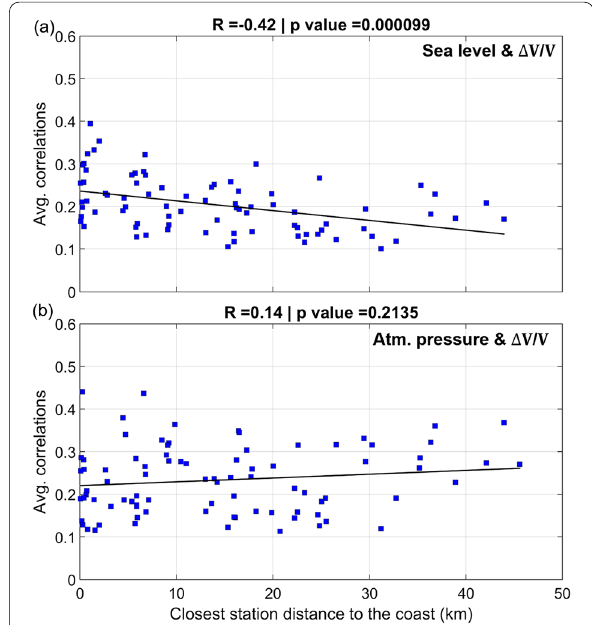
Fig. 7 Scatterplots from step 2 plotting distance from the coast against the correlations between a seismic velocity changes and sea level data and b seismic velocity changes and atmospheric pressure after filtering within the 64- to 274-day period band